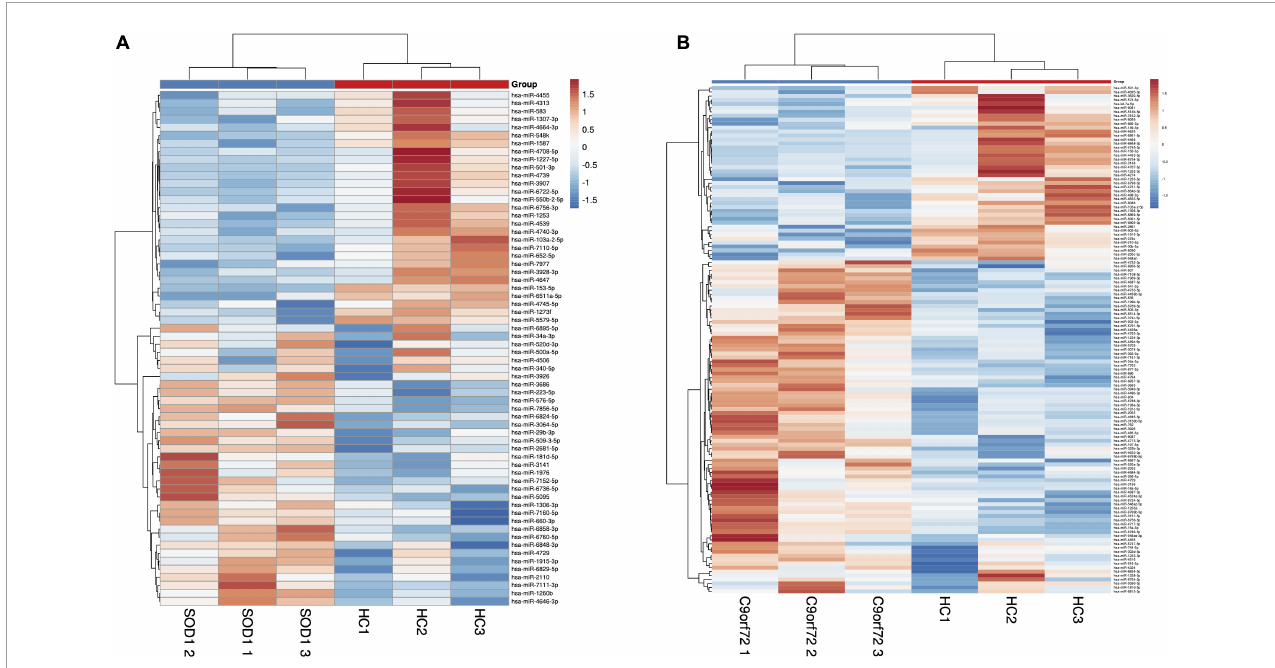
FIGURE2 The heatmap of differentially expressed miRNAs by means of microarray. (A) The comparison of patients with SOD1 -mutated amyotrophic lateral sclerosis (ALS) and healthy controls; (B) The comparison of patients with C9orf72 -mutated ALS and healthy controls. Compared with HCs, we found 64 miRNAs differentially expressed in SOD1 -mutant ALS where 35 of them were upregulated, and 29 of them were downregulated, and 128 miRNAs dysregulated including 84 upregulation and 44 downregulation in patients with C9orf72 -mutated ALS.